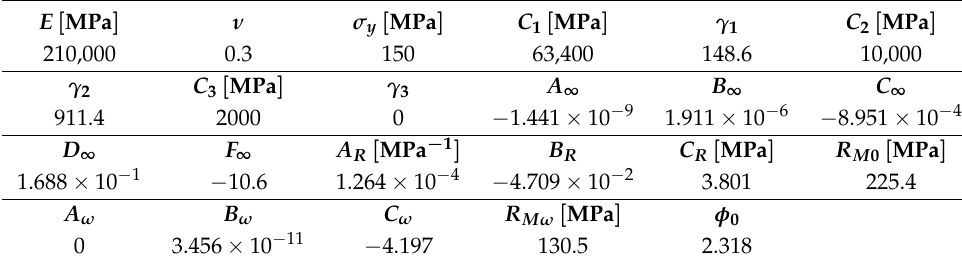
Table 2. Material parameters of the proposed model for